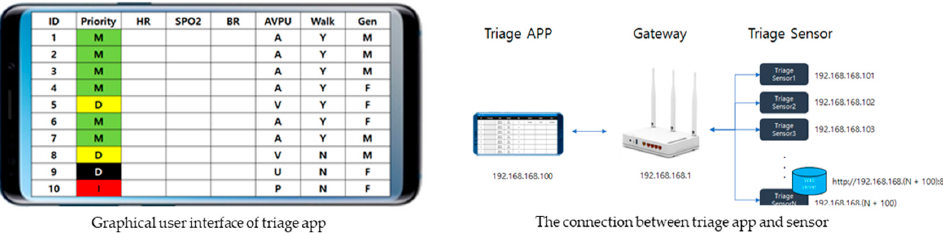
Figure 2. Prototype of Triage Sensor.